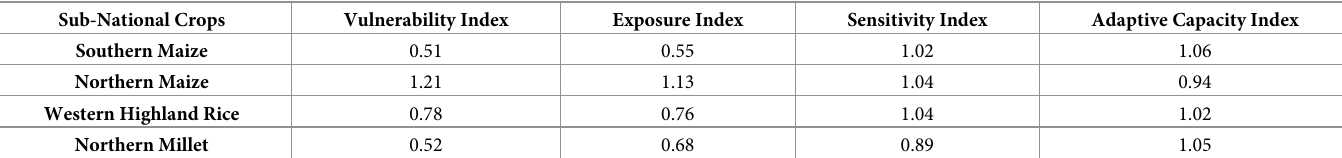
Table 3. Sub-national vulnerability indices at four sub-national